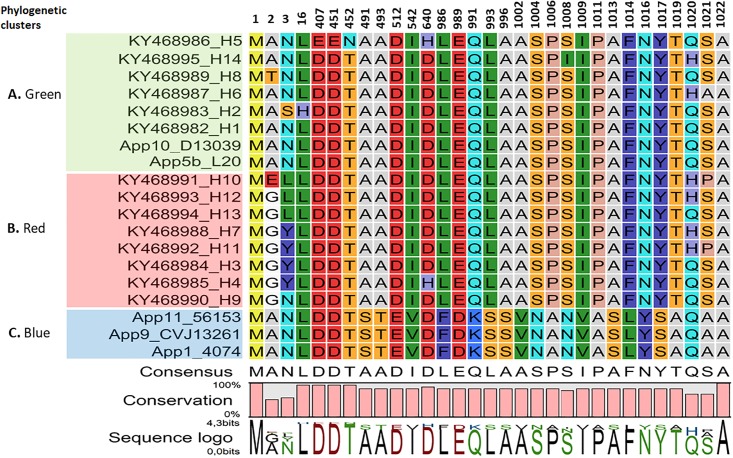
Polymorphisms identified in the amino acid sequence of ApxIA protein.The peptides were grouped according to the haplotypes and phylogenetic clades determined in Fig 2a. The figure presents the localization of amino acid mutations between the first (1) and the final (1022) amino acid of the ApxIA toxin of Brazilian isolates of A. pleuropneumoniae serovar 5 and GenBank serovars 11, 10, 9, 5 and 1.